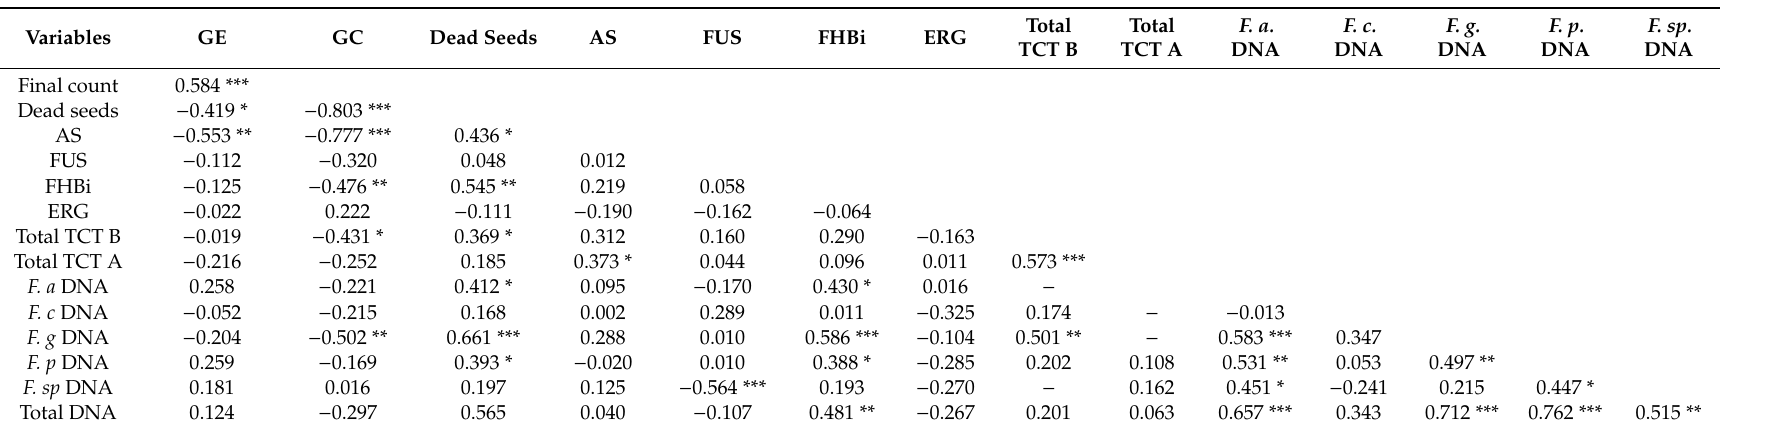
Table 7. Coe ffi cients of correlations between seed quality parameters (germination energy—GE, germination capacity—GC, dead seeds, abnormal seedling—AS,